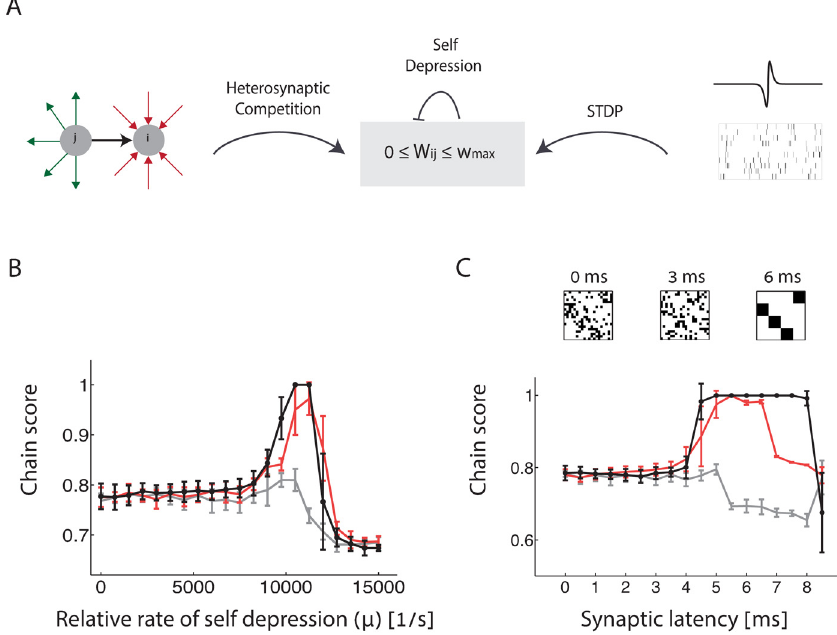
Fig 7. Emergence of synfire chains under the full STDP dynamics. A. Schematic representation of the plasticity rules applied to excitatory synapses. In addition to the mechanisms mentioned in Fig 4, the synapses undergo self depression that weakens their efficacy in proportion to its magnitude. B-C. Chain score of the steady state connectivity, averaged over ten random choices of the initial connectivity. Black traces: complete dynamics (Eq 2); red (gray) traces — power series expansion (Eq 3), truncated to include motifs up to third (second) order. B. Chain score plotted as a function of μ , the relative rate of self-depression (the rate of self depression is given by ημ , where η is the learning rate, see Methods). All other parameters are kept fixed. C . Chain score plotted as a function of the synaptic latency, while keeping all other parameters fixed. Above: three examples of the steady state connectivity obtained in specific simulations, with different values of synaptic latency. Error bars in panels B-C represent the standard deviation of the chain score over the ten initial